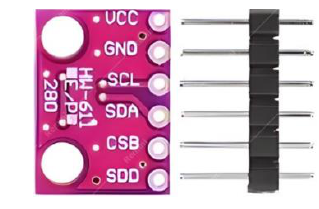
Figure 4. BME280 [22].